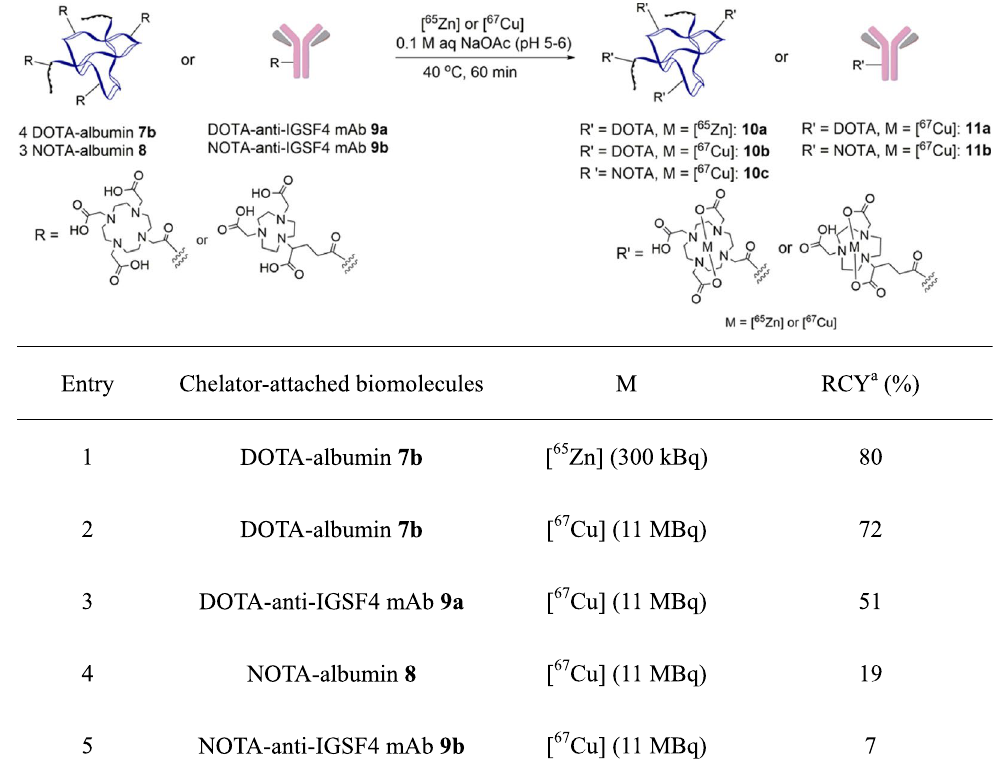
(9a). According to the protocol of one-pot three-component double click labeling of albumin with DOTA (preparation of 7b ), the labeling of anti-IGSF4 antibody with DOTA was carried out. The anti-IGSF4 mouse monoclonal antibody was raised against the extracellular domain of IGSF4 produced by HEK293 cells (Health Science Research Resources Bank, Osaka, Japan). Anti-IGSF4 antibody in PBS (3 × 10 − 5 M) was centrifuged with Amicon ® with 14k rpm for 12 min and diluted with distilled water to give anti-IGSF4 antibody in water (2 × 10 − 5 M) prior to use. The labeling was performed with the antibody in water. The DOTA-attached anti-IGSF4 antibody 9a in water (2 × 10 − 5 M for each) were stocked for radiolabeling. One-pot three-component click reaction for attaching NOTA to anti-IGSF4 antibody (9b). According to the same protocol of one-pot three-component double click labeling of anti-IGSF4 anti- body with DOTA (preparation of 9a ), the labeling of anti-IGSF4 antibody with NOTA was carried out. The labe- ling was performed with the antibody in water. The NOTA-attached anti-IGSF4 antibody 9b in water (4 × 10 − 6 M for each) were stocked for radiolabeling.